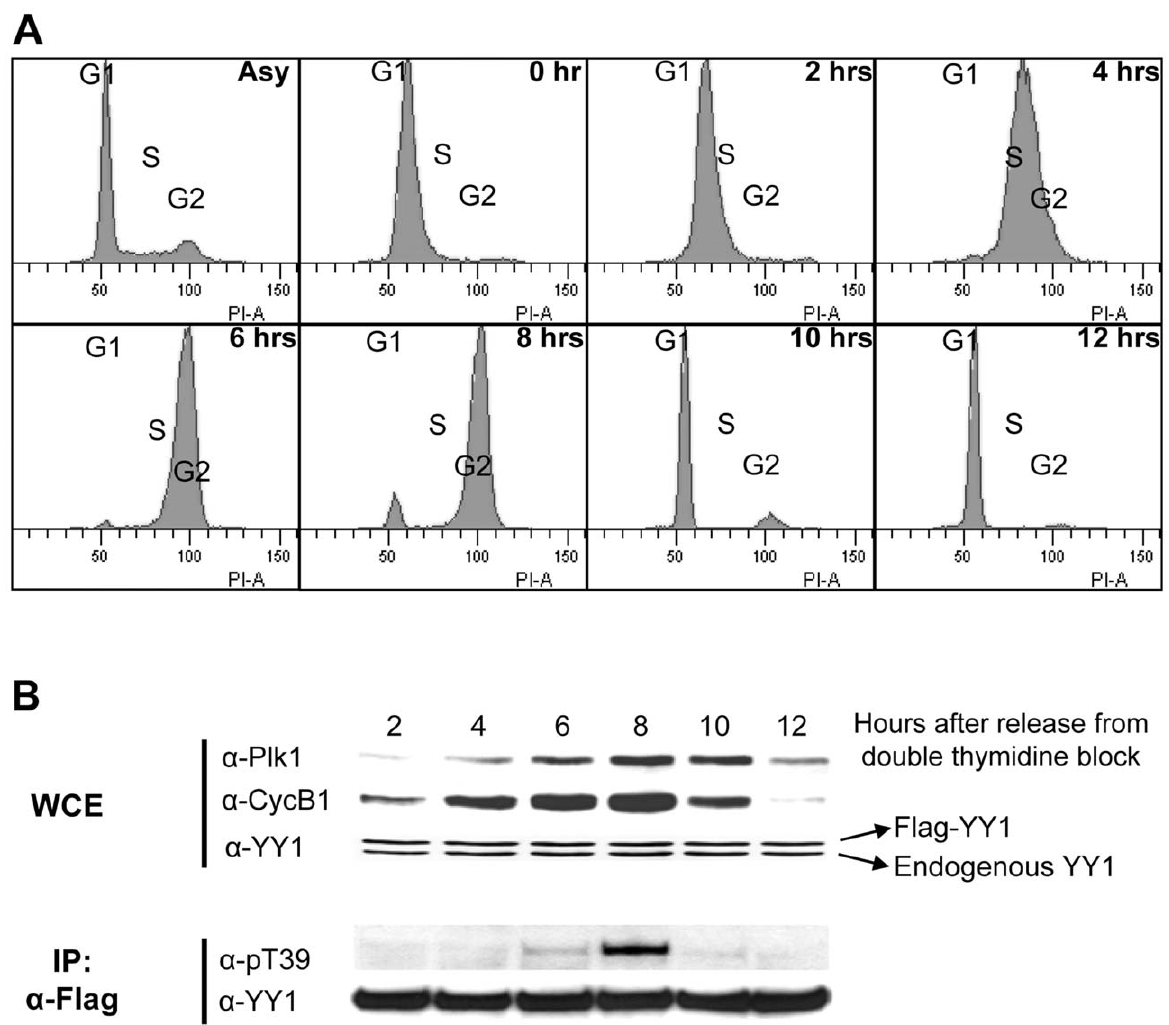
Figure 5. Threonine 39 phosphorylation on YY1 peaks at G2/M transition. Stable HeLa-Flag-YY1 cells were synchronized by double- thymidine block and then released. ( A ) Analysis of the cell-cycle progression of HeLa cells released after double-thymidine block using fluorescence- activated cell sorting. Cells were stained with propidiumiodide andanalyzed based on their DNA content. An asynchronous population of cells was used as a control. ( B ) Whole cell extracts were prepared from HeLa-Flag-YY1 cells collected at the indicated times after release from double-thymidine block. Total WCE were analyzed on a Western blot after SDS-PAGE separation, and probed with anti-Plk1, anti-Cyclin B1, and anti-YY1 antibodies. Flag-YY1 was immunoprecipitated from the extracts of each time point, and then analyzed on a Western blot using anti-pT39 and anti-YY1 antibodies.